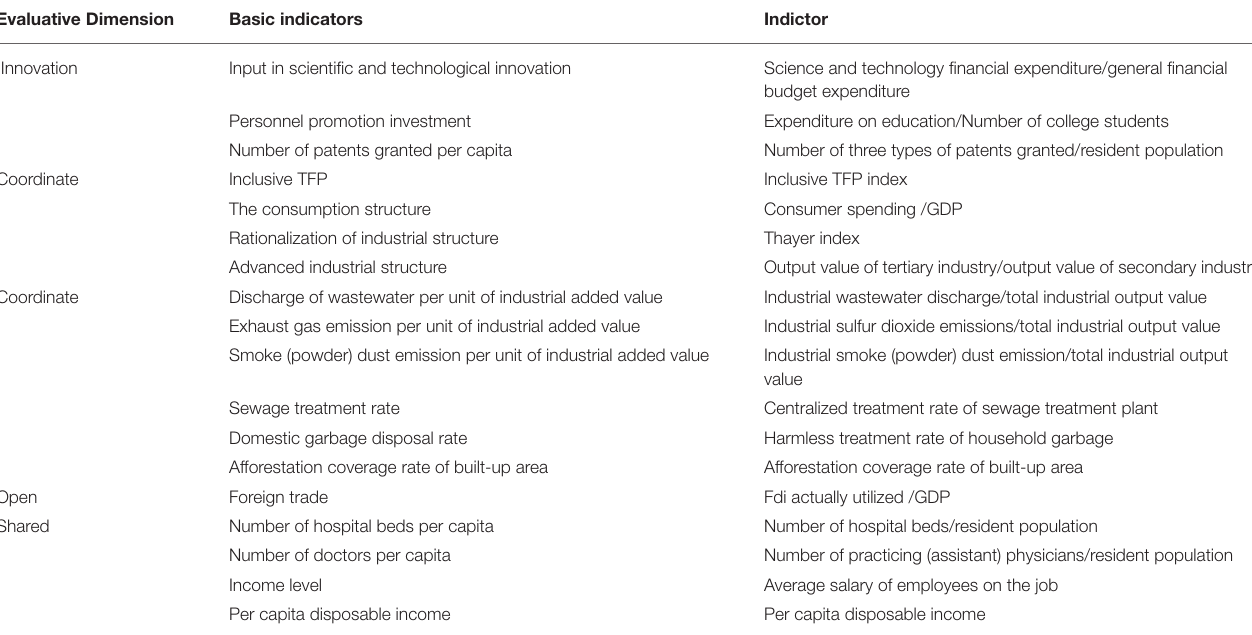
TABLE 1 | Evaluation system of high-quality development of urban agglomeration. Evaluative